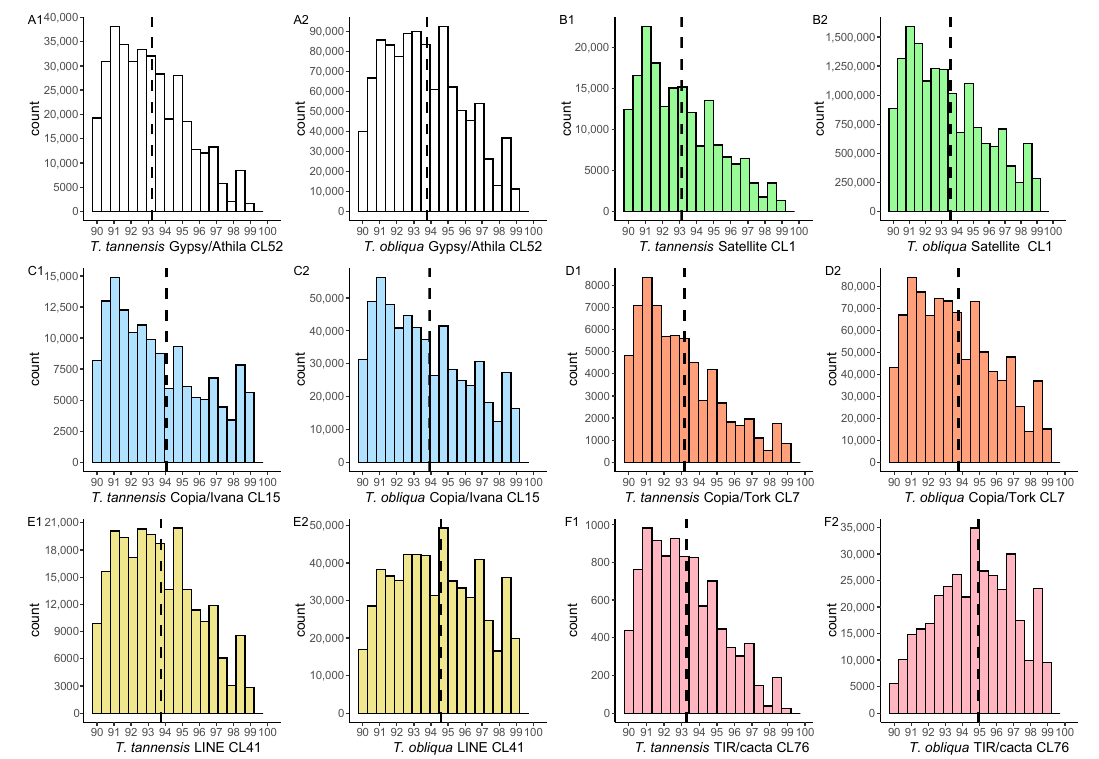
Figure 3. Intrafamily heterogeneity of repeats in Tmesipteris . ( A1 – F2 ) Histograms of percentage sequence similarity for read pairs in % ( x -axis) from selected repeat families from T. tannensis and T. obliqua . The y -axis ‘count’ refers to the number of reads and dashed lines indicate the median heterogeneity values per cluster (CL).